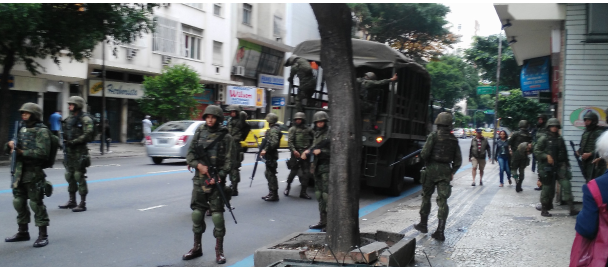
Figure 5. Troops stationed in Copacabana for the